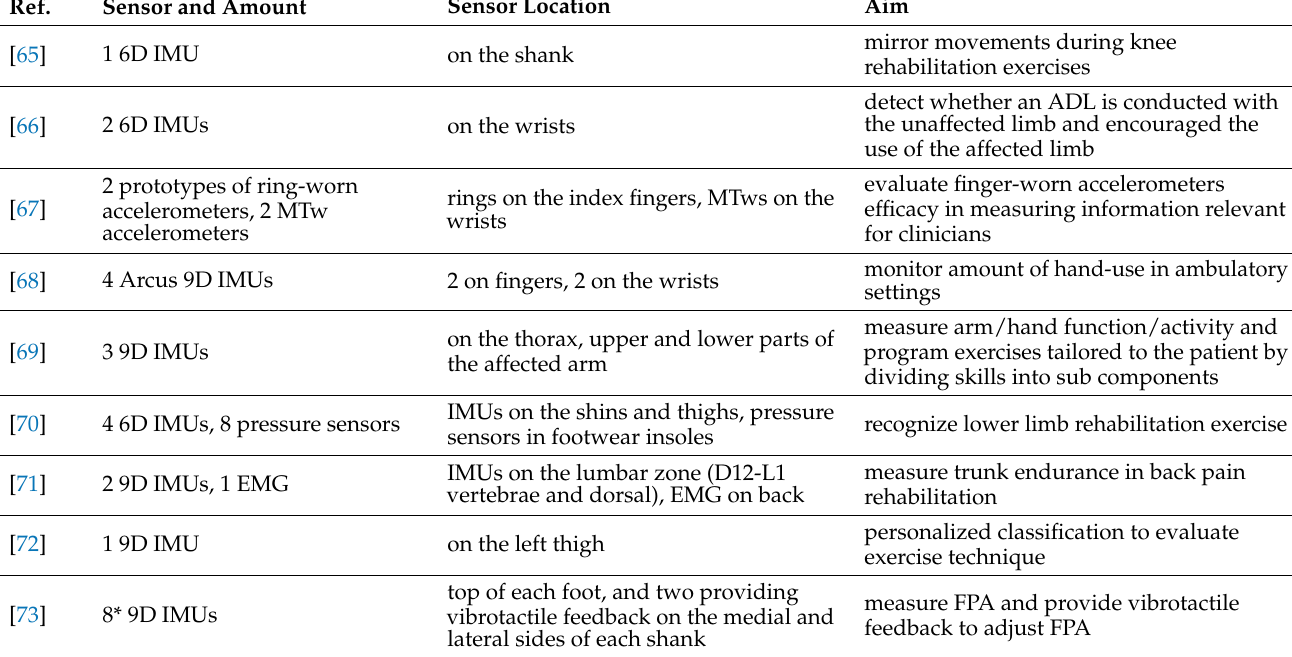
Table 8. Study characteristics for studies on rehabilitation. * = the system contains eight IMUs but only six IMU locations are